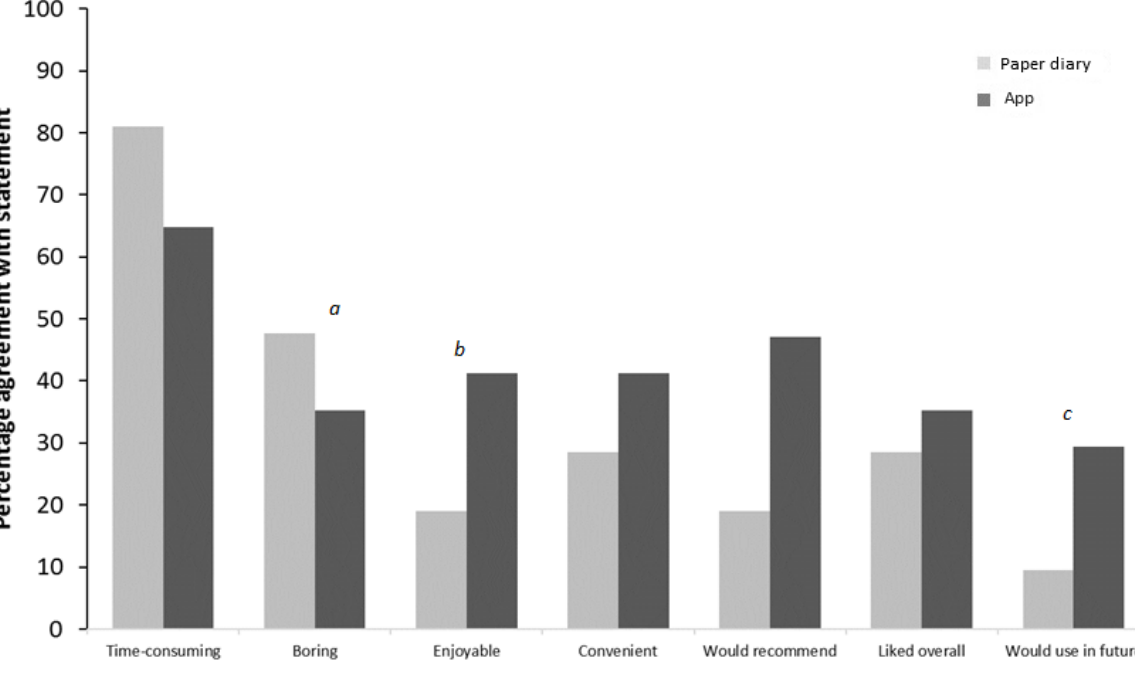
Figure 4. Response to questionnaires in relation to participants’ general feelings towards using either the paper diary or app. For statements a, b, and c, there is a significant difference between the use of the paper diary and the app (a: P =.031; b: P =.04; c: P